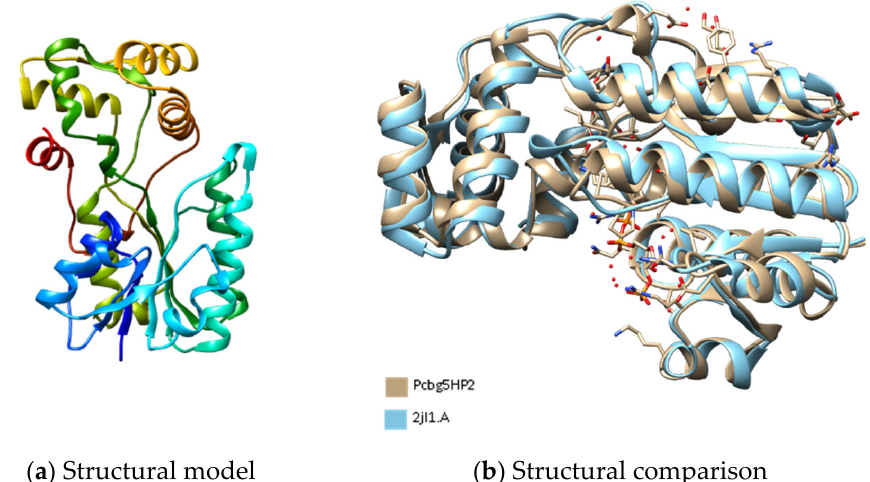
Figure 2. The three-dimensional structure analysis of PCBG5HP2. ( a ) The structural model of PCBG5HP2 was constructed using the Phyre2 server with 17% sequence identity to the structures of 2JL1 as templates [44]. Image coloured by rainbow N → C terminus. ( b ) Comparative structural analysis between PCBG5HP1 model and Citrobacter sp. triphenylmethane reductase (PDB 2JL1).